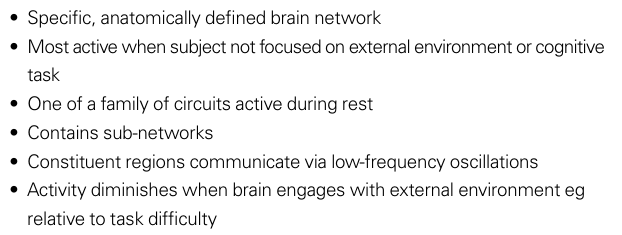
Table 2 | Characterization of default